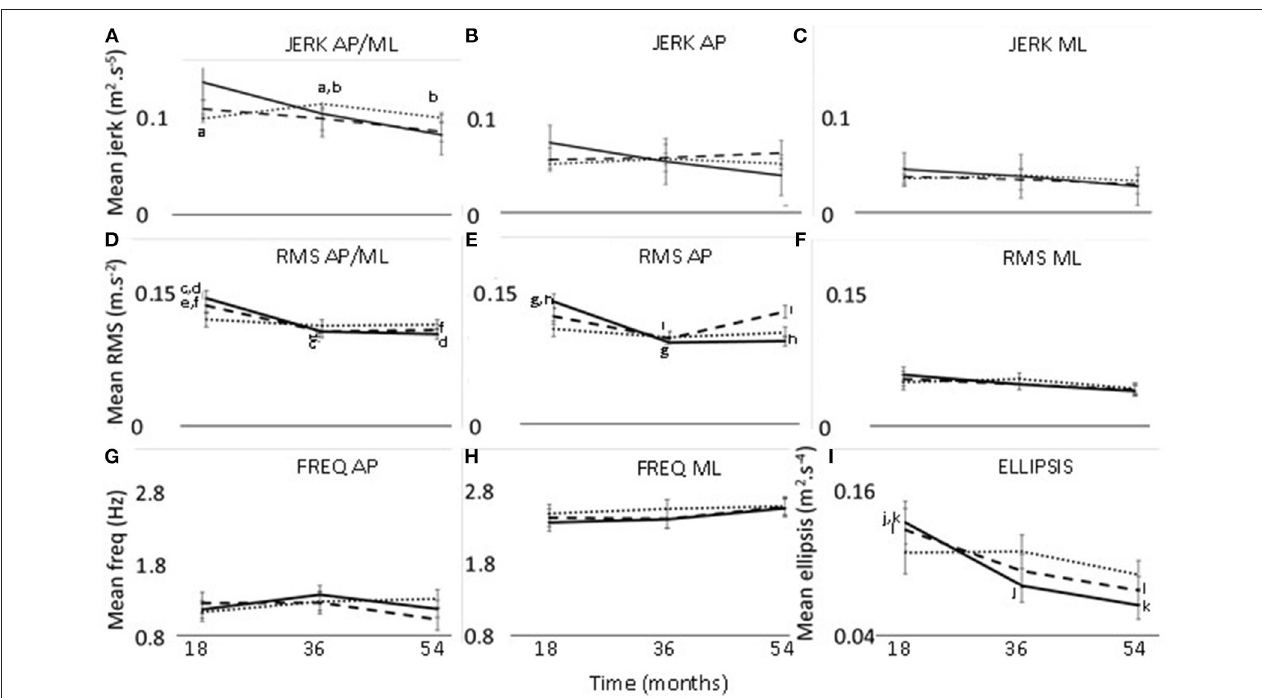
( Figure 1A ). The RMS parameters along the combined axis decreased significantly from 18 to 36 months for 30 s ( p = 0.002 effect size = 0.44, power = 70.2%) and 60 s ( p = 0.022 effect size = 0.35, power = 48.0%) ( Figure 1D ). These RMS parameters also decreased from 18 to 54 months (30 s p < 0.001 effect size = 0.46, power = 83.9%, 60 s p = 0.018 effect size = 0.32, power = 50.0%). Additionally, along the AP axis, the 30 s RMS decreased from 18 to 36 months ( p < 0.001 effect size = 0.56, power = 86.9%) and 54 months ( p < 0.001 effect size = 0.53, power = 89.6%) ( Figure 1E ). However, for 60 s RMS increased from 36 to 54 months ( p = 0.011 effect size = 0.19, power = 51.2%) ( Figure 1E ).